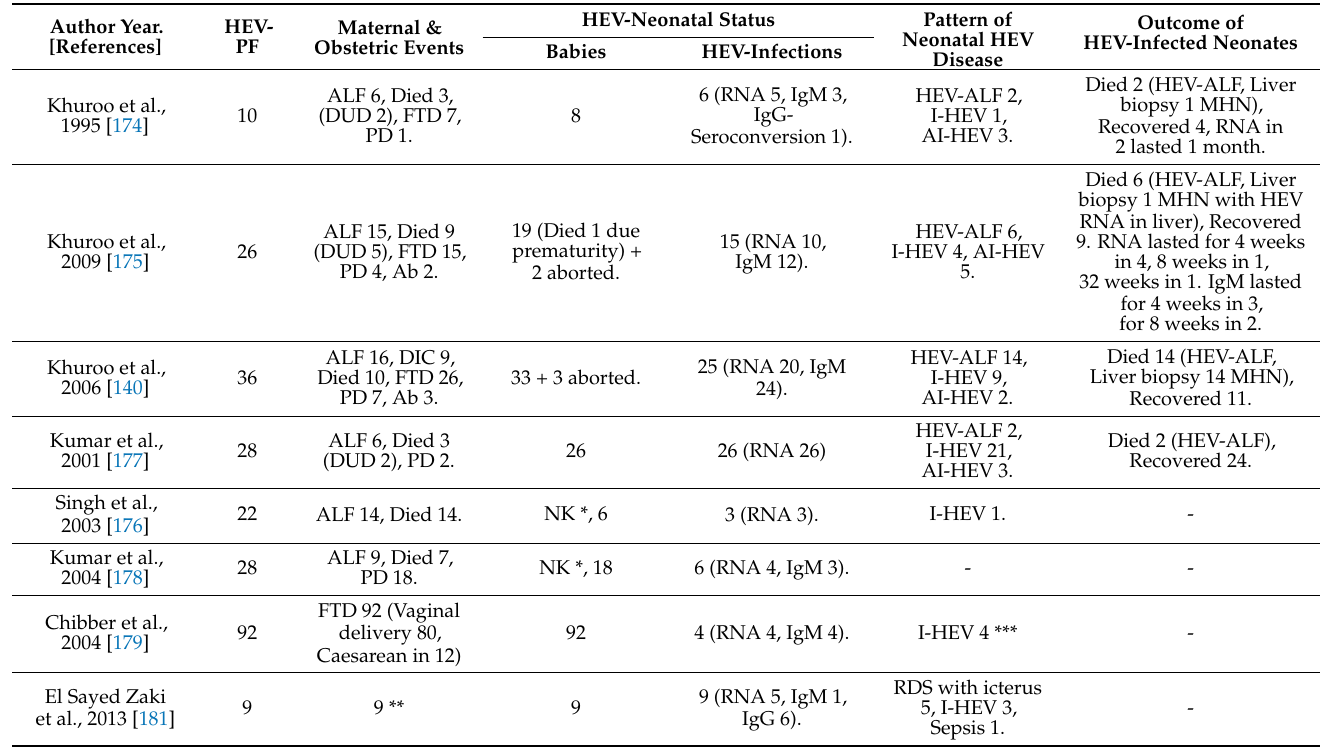
Table 3. Vertical transmission of HEV and maternal and obstetric events and neonatal